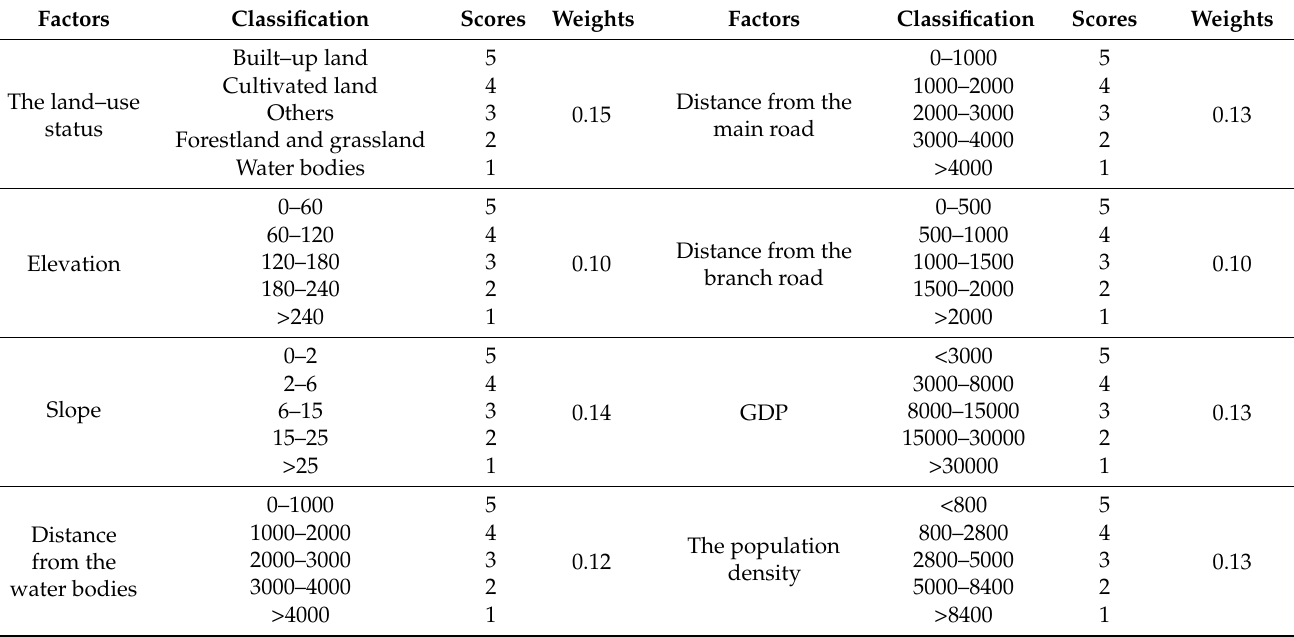
Table 1. Resistance factor classification, scores, and